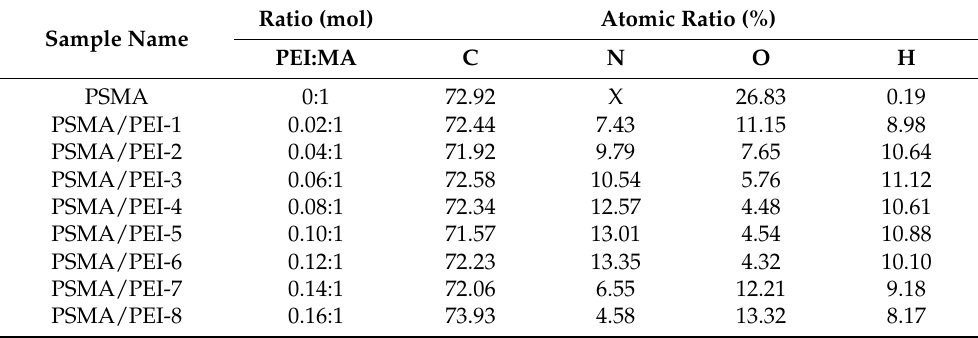
Table 2. EA of PSMA/PEI core–shell nanoparticles based on the addition of polyethylene imine